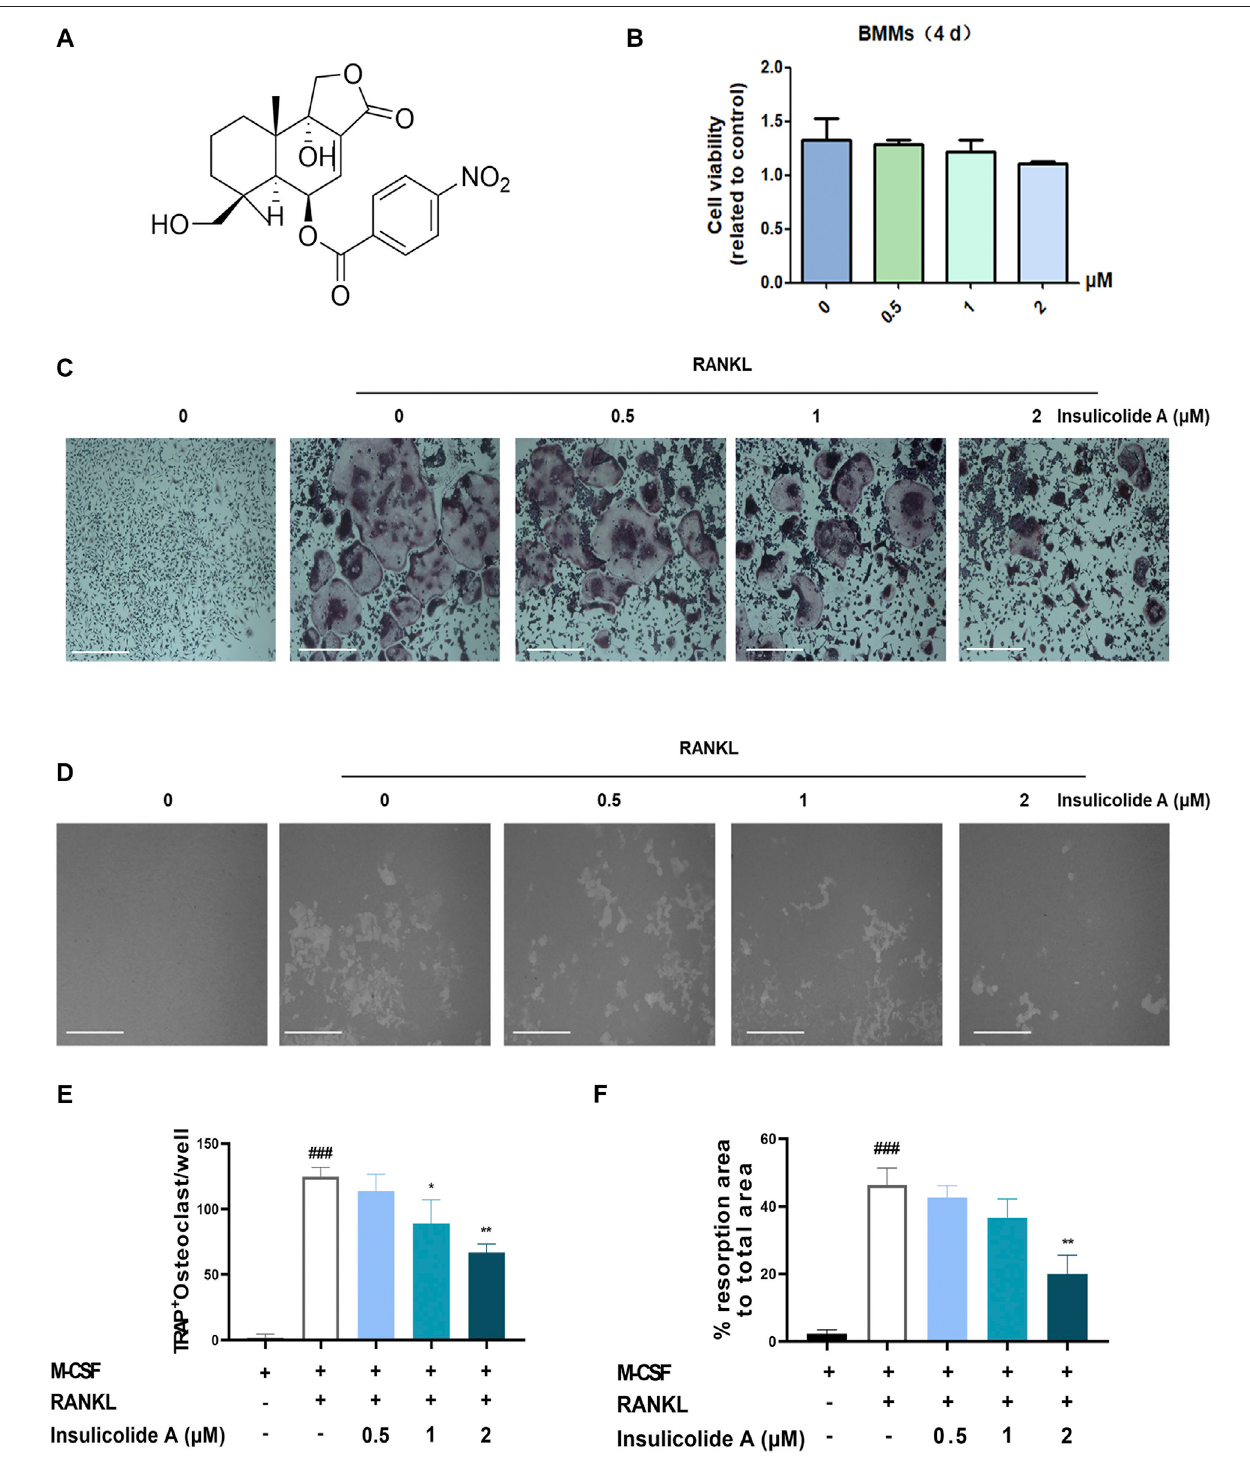
FIGURE 1 | Insulicolide A inhibited receptor activator of nuclear factor- κ B ligand (RANKL)-induced osteoclastogenesis in vitro . (A) The chemical structure of insulicolideA. (B) Thecellviabilityof0.5 – 2 μ MinsulicolideAinbonemarrowmonocytes(BMMs)for4 days weremeasured. (C,E) Images andnumberofTRAP-positive multinucleatedcells(nuclei > 5)weretakenandcalculated. (D,F) Imagesandareasofboneresorptionbyosteoclastsonthehydroxyapatite-coatedsurfacesweretaken and quanti fi ed. The data are shown as means ± SD ( n (cid:2) 3 independent experiments, containing three replicate samples each). ### p < 0.001 vs. nontreatment groups, * p < 0.05, ** p < 0.01 vs. RANKL-induced groups.